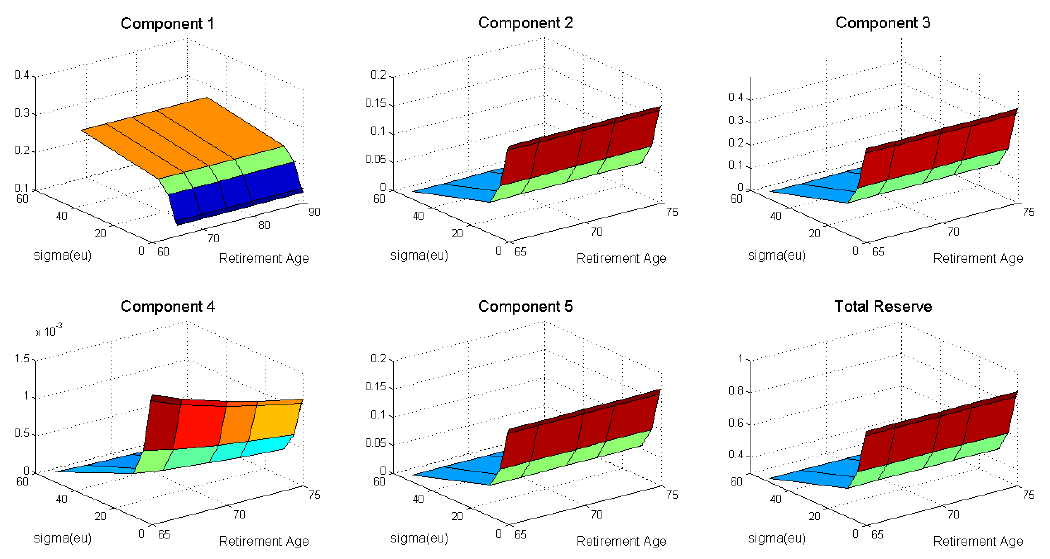
Figure 7. Sensitivity analysis with respect to σ ( eu ) by components and total